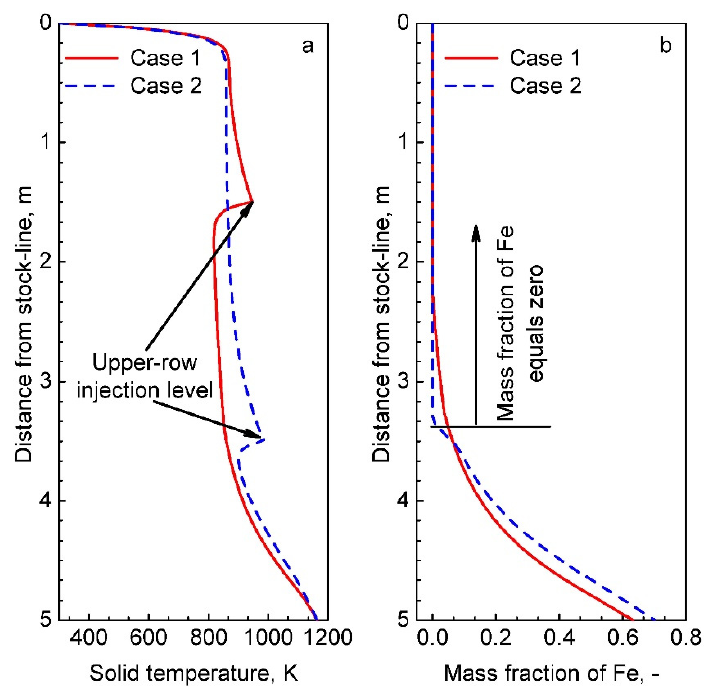
Figure 5. Distributions of solid temperature ( a ) and mass fraction of metallic iron (Fe) in the burden ( b ) under the conditions of two representative cases.